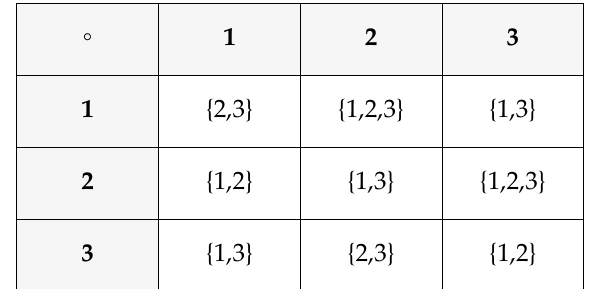
Table 9. Join left almost-hypergroup.